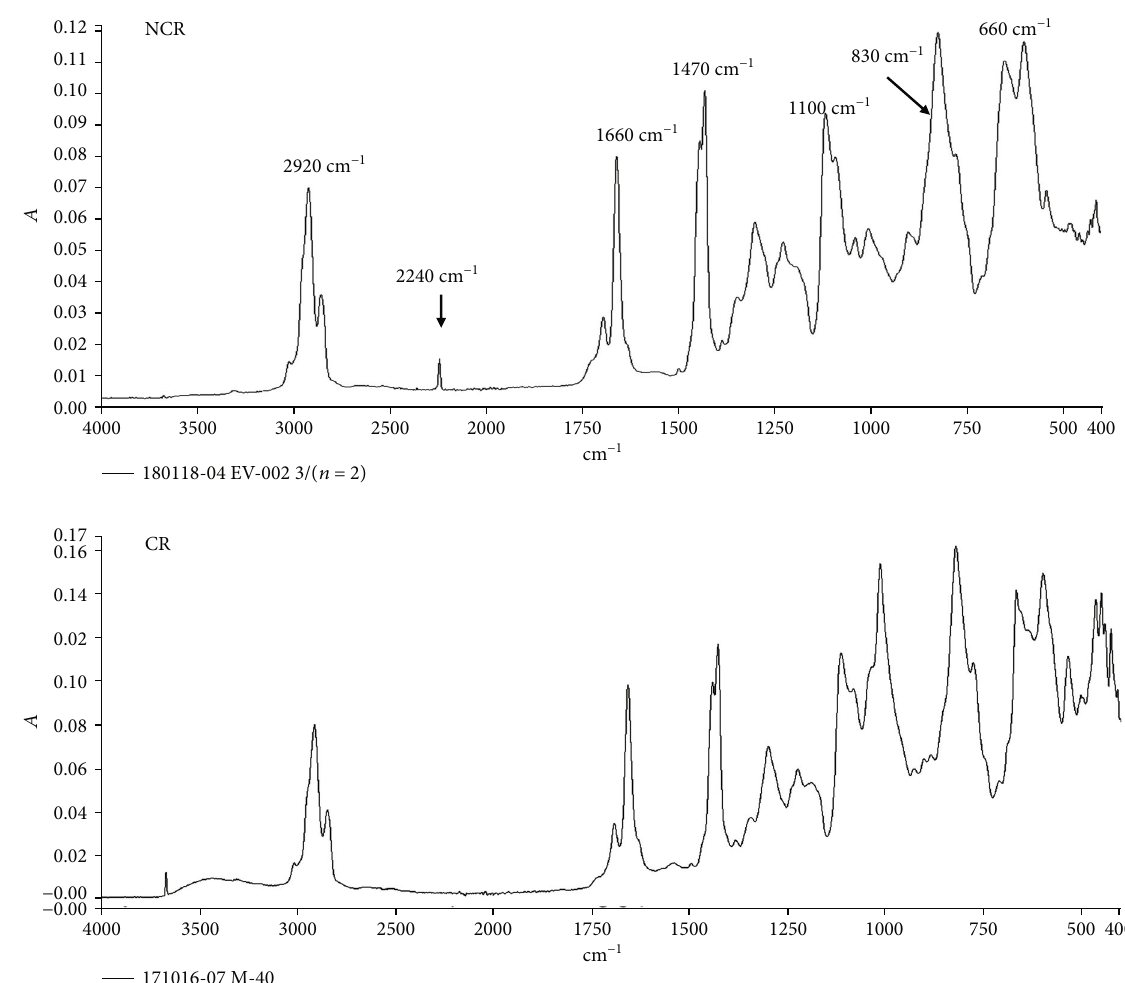
Figure 1: FTIR spectra of acrylonitrile-chloroprene rubber (NCR) and chloroprene rubber